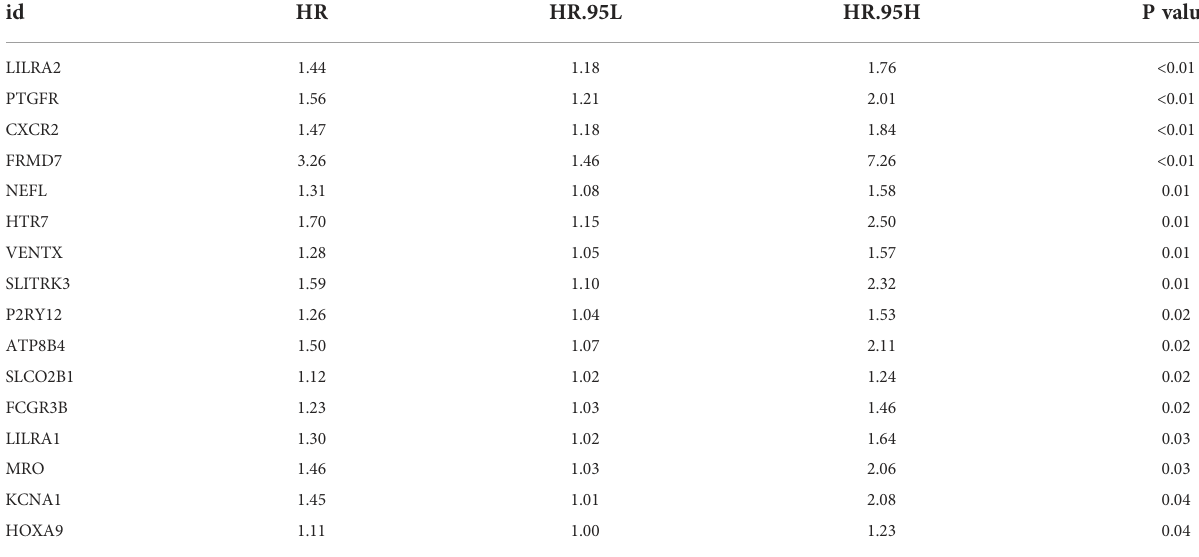
TABLE 1 Genes meeting the criteria of univariate Cox